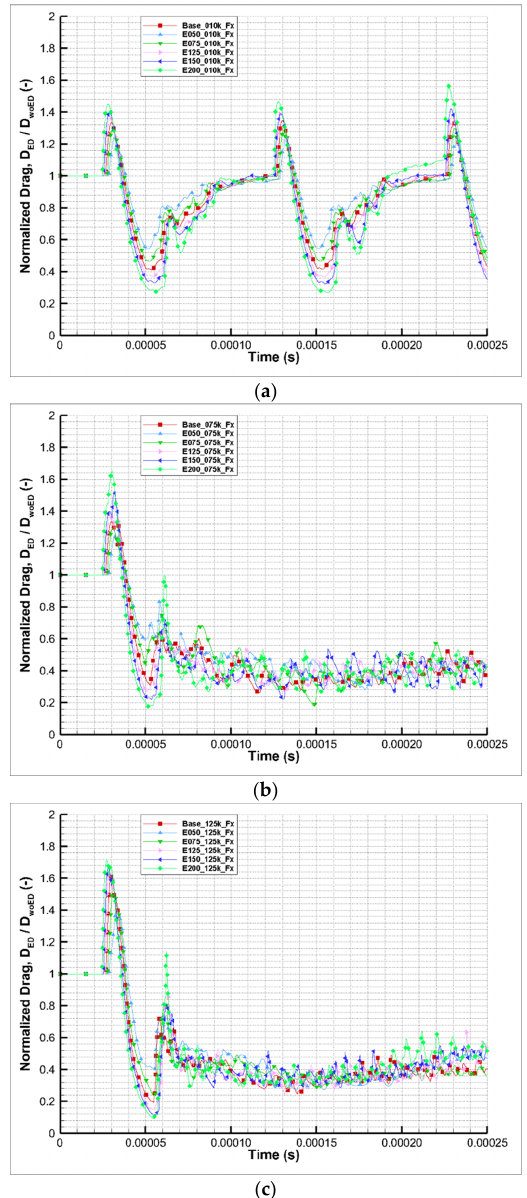
Figure 11. Normalized drag vs. deposition energy for various deposition frequencies ( a ) 10 kHz, top; ( b ) 75 kHz, middle; ( c ) 125 kHz, bottom. ( b ) 75 kHz, middle; ( c ) 125 kHz,